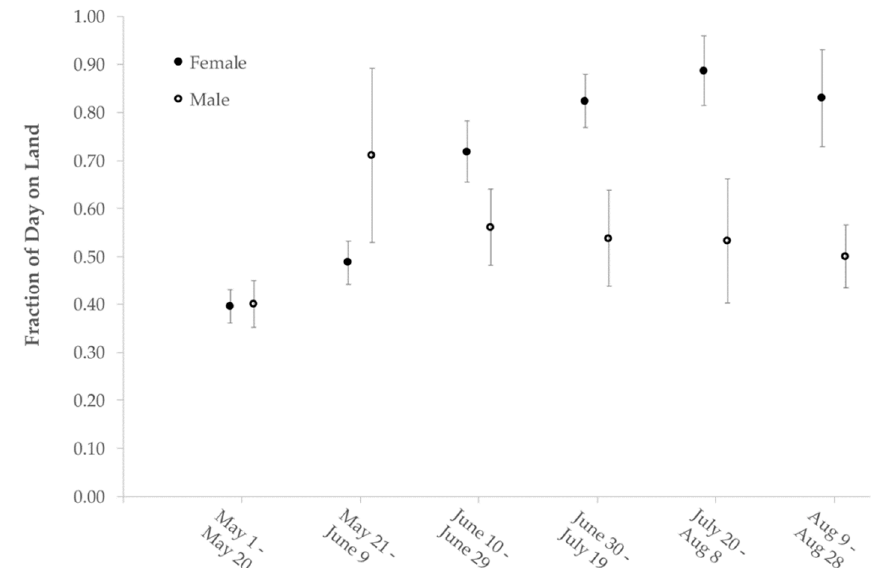
Figure 5. The proportion of time 19 female and 10 male wood turtles ( Glyptemys insculpta ) were on land (mean ± SE) based on GPS receiver locations and temperature loggers in northeastern Minnesota from 16 June 2015 to 17 July 2015 and 5 May 2016 to 28 August 2016.